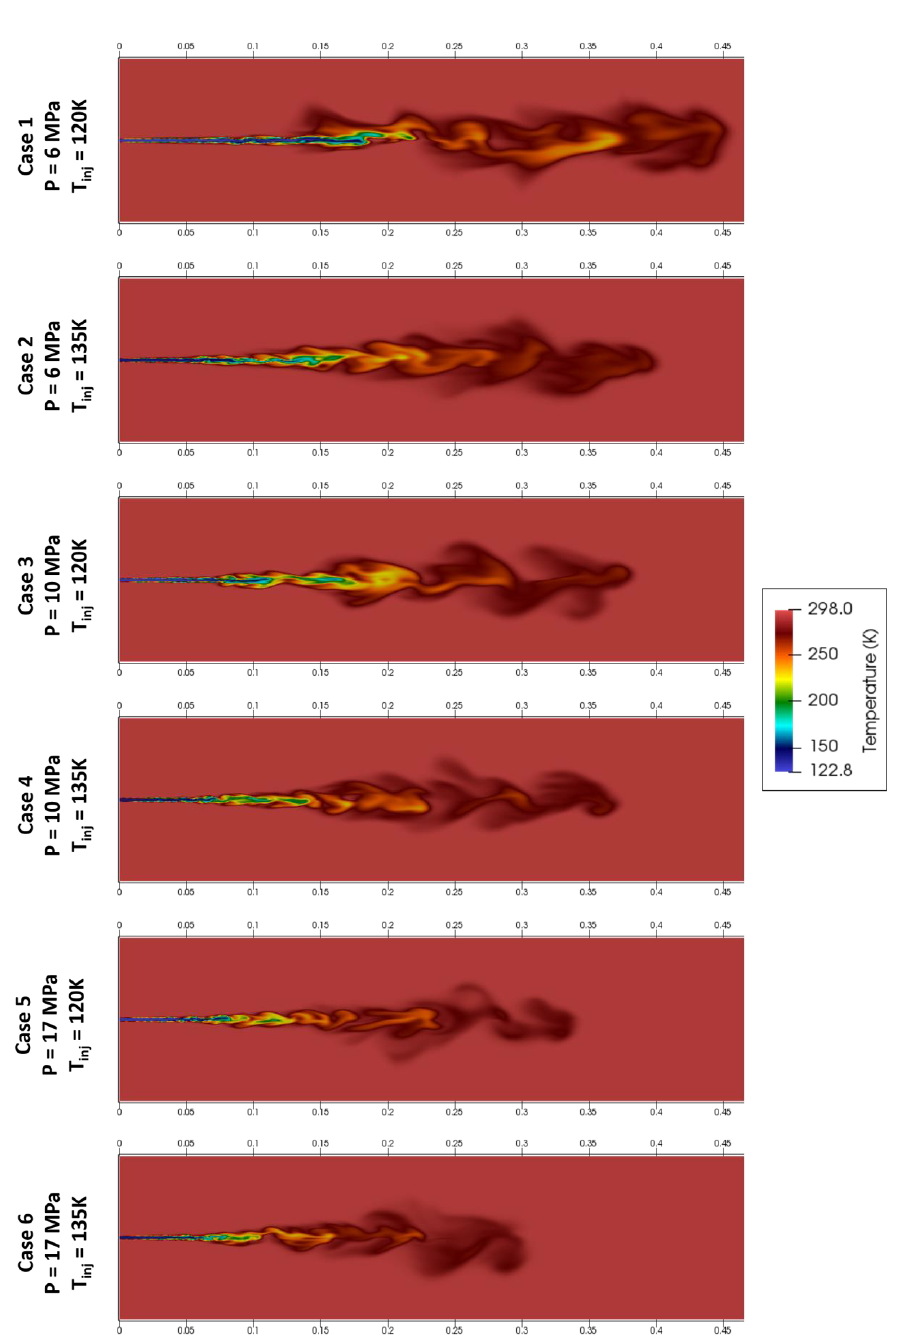
Figure 16. Temperature distribution for all the cases at cut section plane passing through the axis of cylindrical mesh (chamber) at t = 1 s from